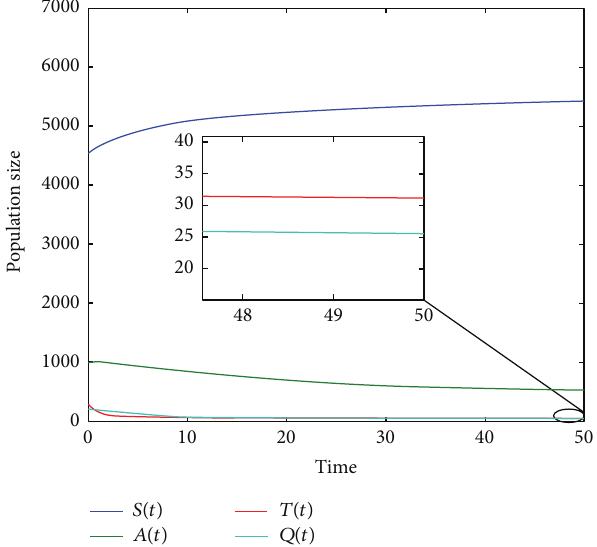
Figure 3: When 𝑅 0 ≥ 1 , the alcoholism equilibrium 𝐸 ∗ = (4466, 476, 32, 26) corresponding to the given parameters is globally asymptotically stable ( 𝛽 = 0.3, 𝛿 = 0.2 , and 𝑅 0 = 1.08511 ).